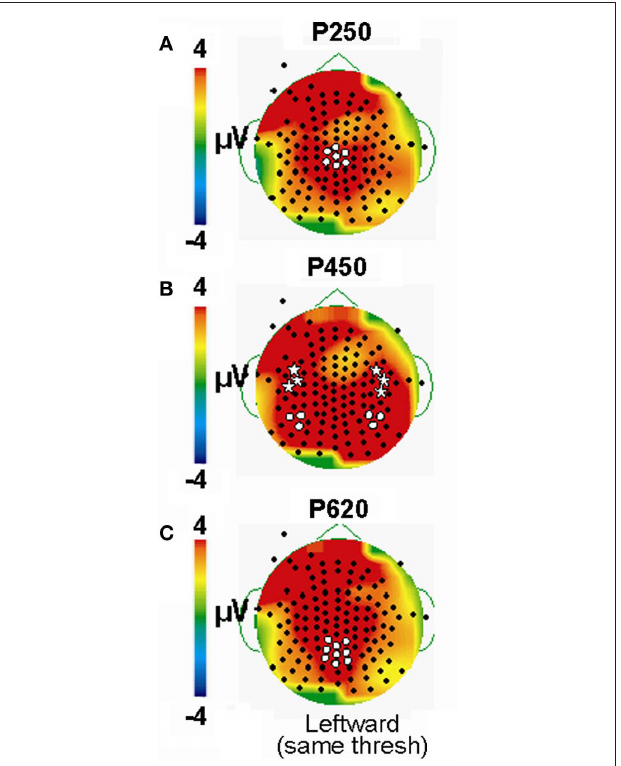
FiguRE A2 | Leftward gaze condition at the same threshold as Blink condition from Figure 3. Leftward gaze results in much greater amplitude than the Blink condition. White circles identify posterior temporal, while stars denote anterior temporal electrode clusters whose ERP data were used in